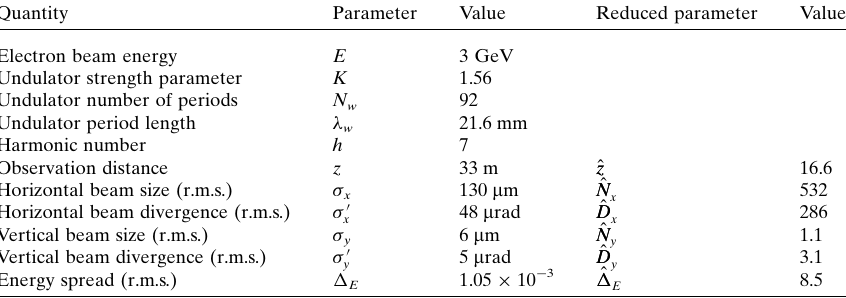
Table 1 Main parameters of the NCD-SWEET beamline at ALBA; reduced quantities based on equations (2) and (11) are also reported.